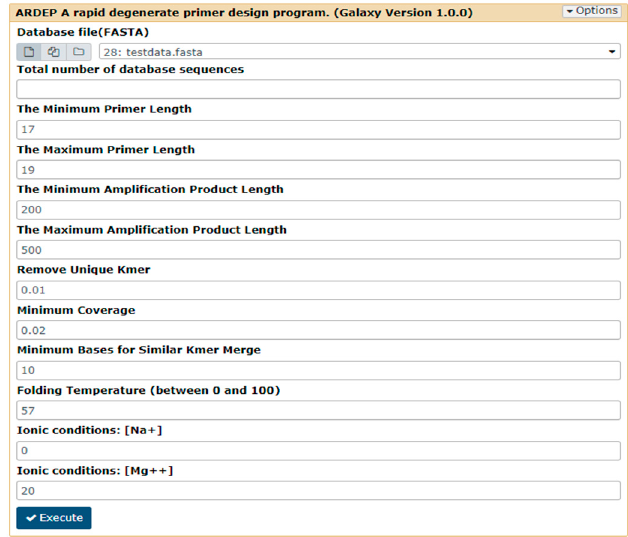
Figure 2. The k -mer-based primer design tool interface. The default values for program operation parameters are shown in the figure.